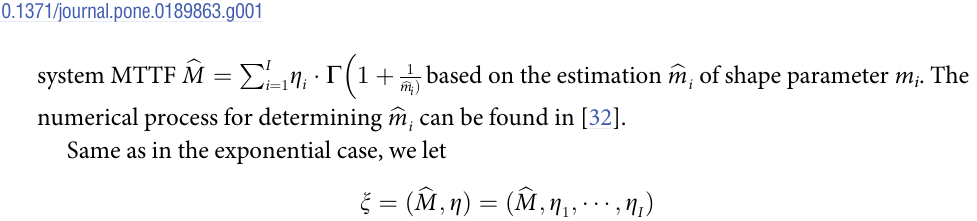
based on the estimation b m